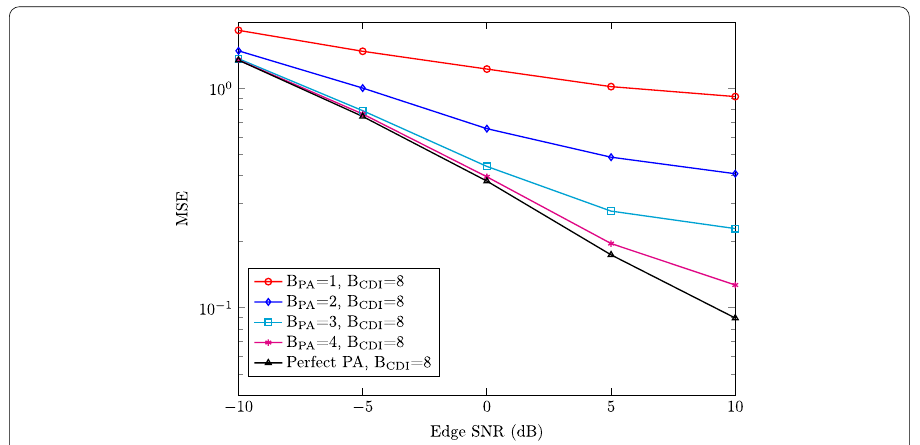
Fig. 15 Impact of bit number of PA quantization in MSE performance of the proposed scheme with flr = 0.167 , N t = 2 and B CDI = 8